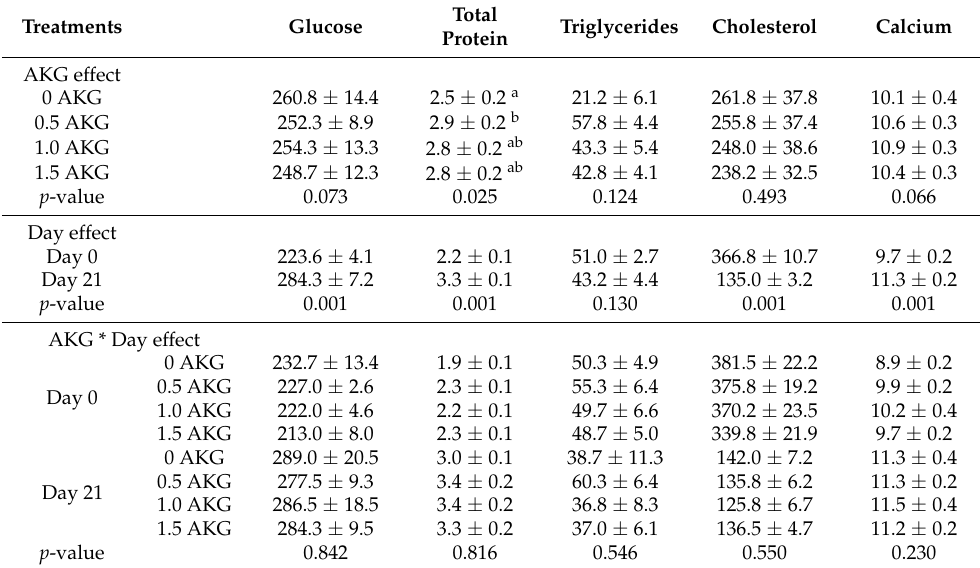
Table 5. Effects of in ovo feeding of α -ketoglutaric acid (AKG) on glucose, total protein, triglyceride, cholesterol, and calcium concentrations in plasma on day 0 and day 21 of age